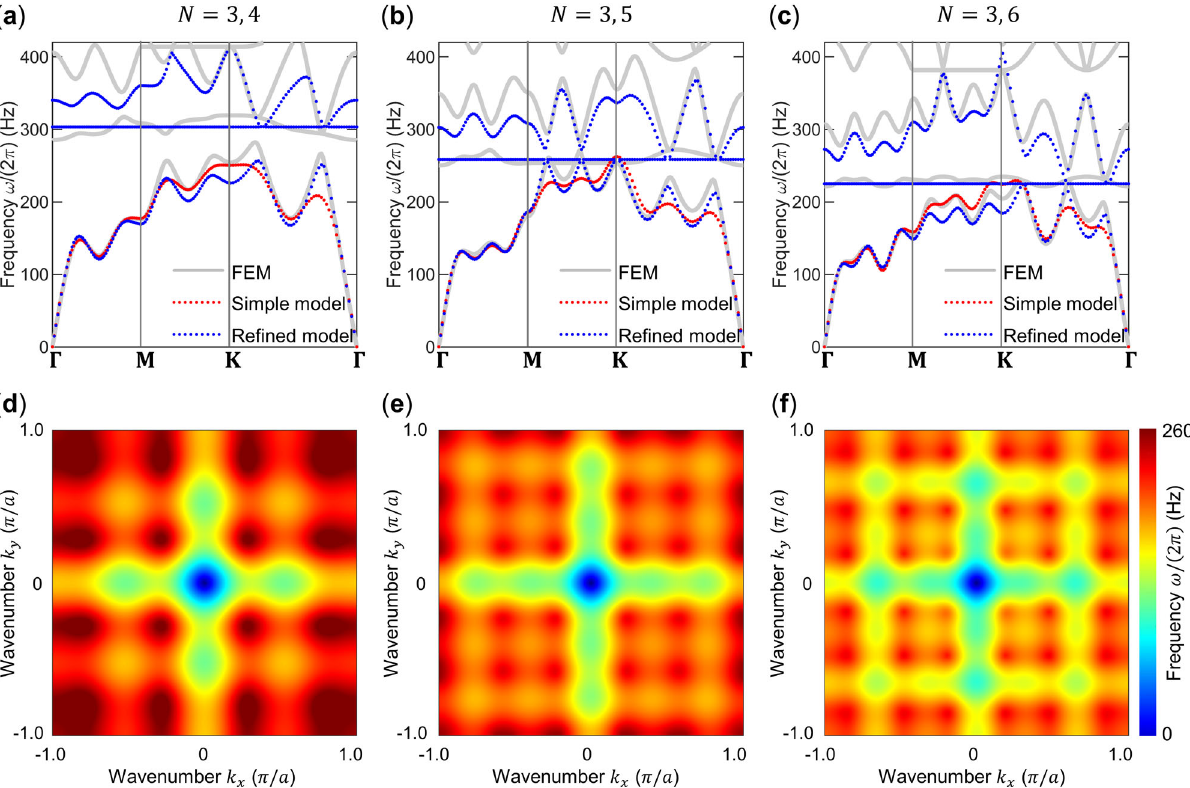
Fig. 5 Calculated phonon dispersion relations for metamaterial structures as shown in Fig. 2. Compared to the dispersion relations shown in Fig. 3, two different beyond-nearest-neighbor interactions are present simultaneously here. a – c correspond to N ¼ 3 and N ¼ 4 simultaneously, N ¼ 3 and N ¼ 5 simultaneously, and N ¼ 3 and N ¼ 6 simultaneously, respectively. Results from the numerical calculations (gray), the simple discrete model (red), and the re fi ned analytical model (blue) are compared. d – f False-color representations of frequency versus wavenumber k x and k y from the numerical calculations. The behavior is due to the combined action of two different beyond-nearest-neighbor